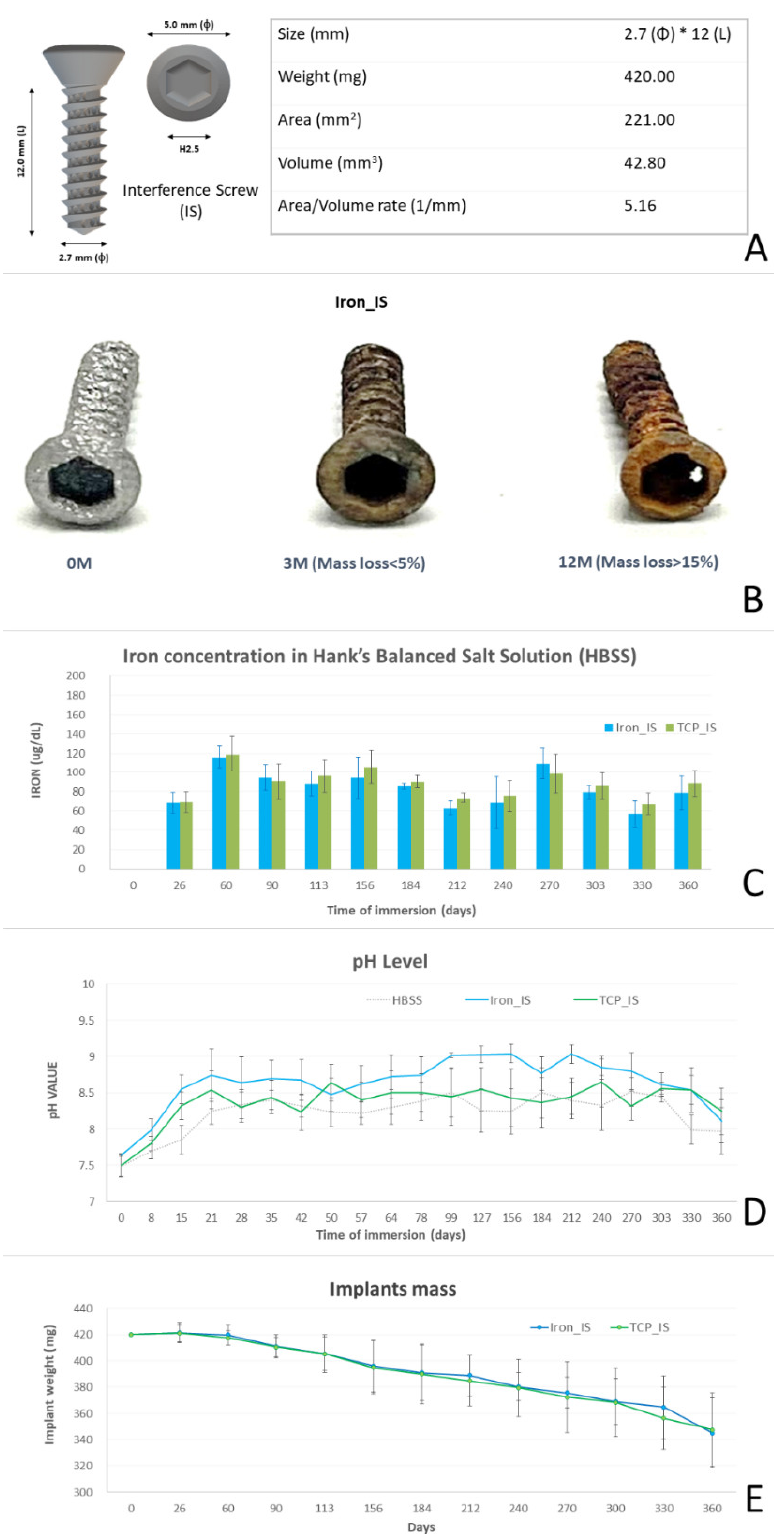
Figure 1. ( A ) Specifications of interference screws (ISs) used in this study. ( B ) Gross appearance of a pure iron bioabsorbable interference screw from an in vitro immersion test in a 12-month period.